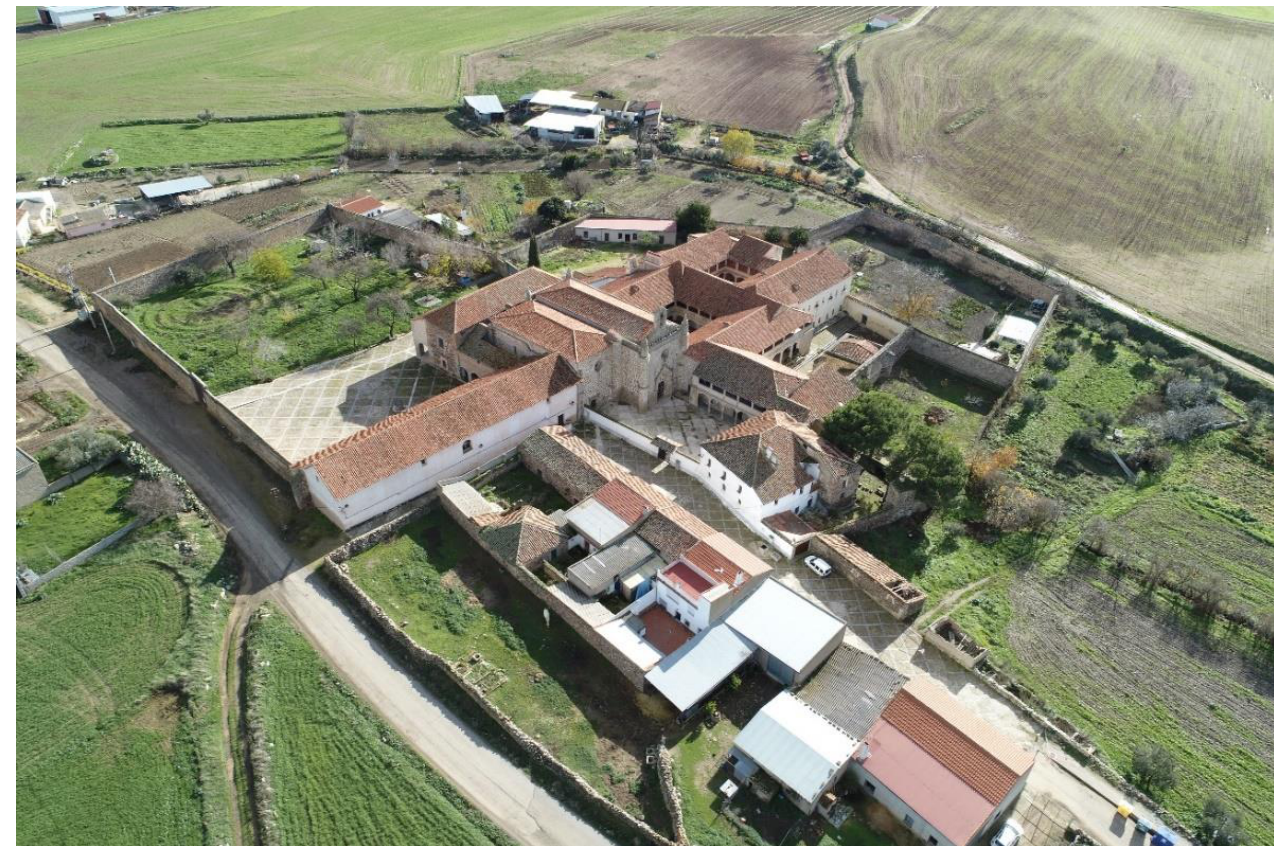
Figure 1. Aerial photo of the monastic complex,